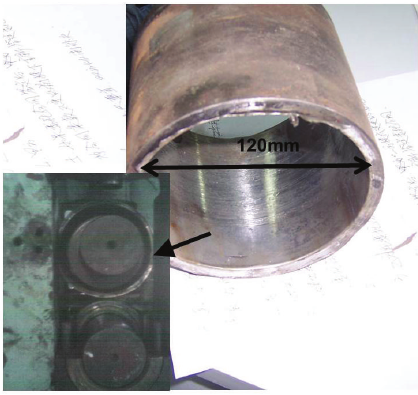
Figure 8: Amount under the pressure caused by uneven edge burr.